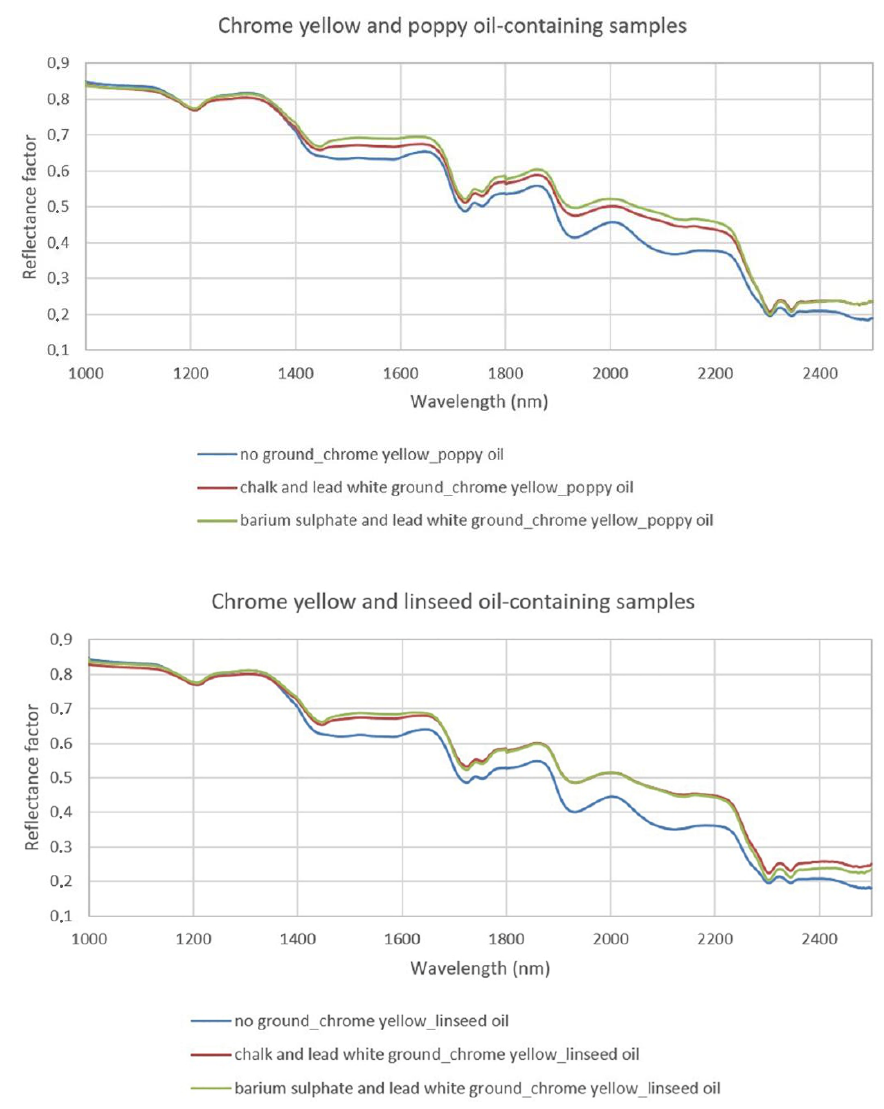
Figure 2. Fibre optic reflectance spectroscopy (FORS) spectra acquired from the different experimental samples (in y-axis, all commas used in decimals, all commas need to be changed into dots, the same as other figures)